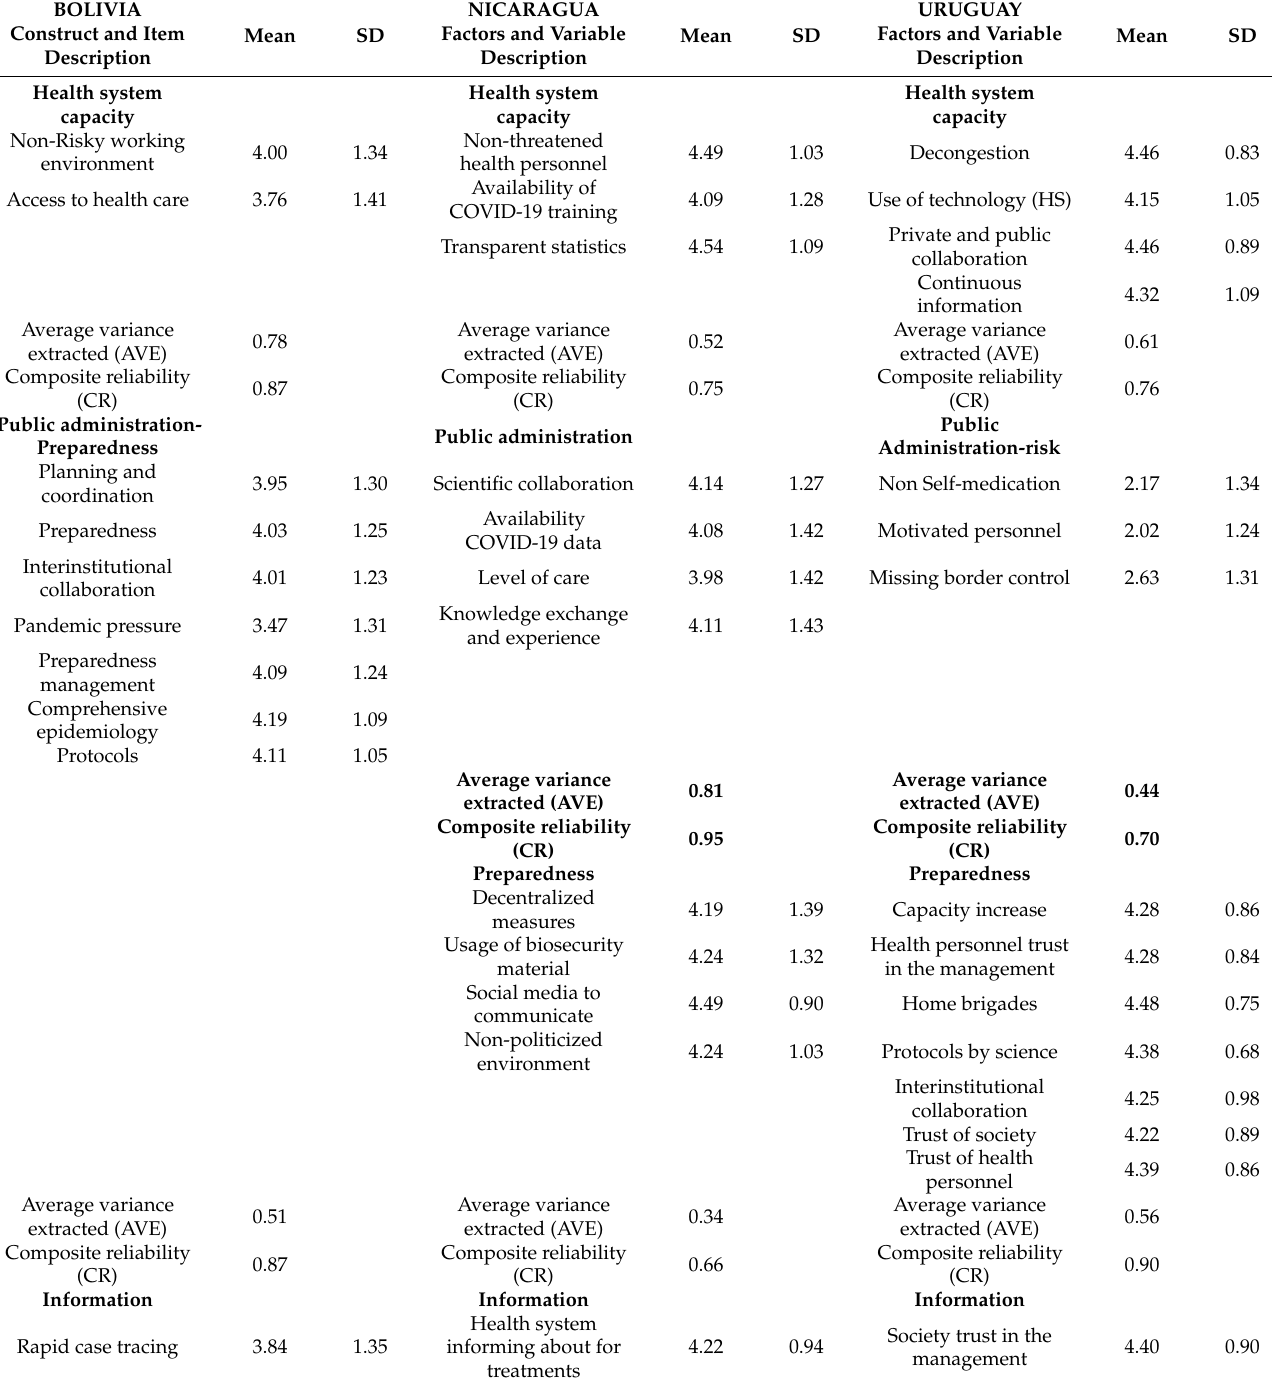
Table A3. Exploratory factor analysis, mean, standard deviation, average variance extracted, and composite